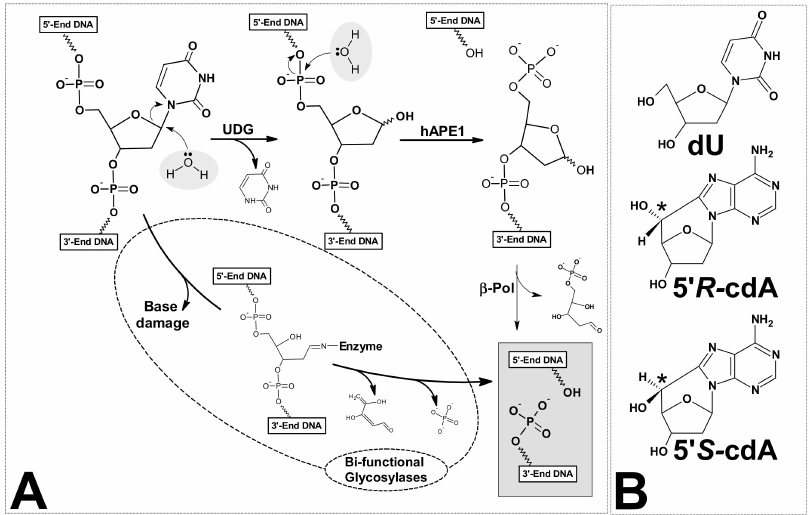
Figure 1. ( A ) Graphical representation of base excision repair system’s (BER) initial step. Di ff erence between mono- and bi-functional glycosylases action; and ( B ) structure of two cdA diastereomes: 5 (cid:48) R and 5 (cid:48) S